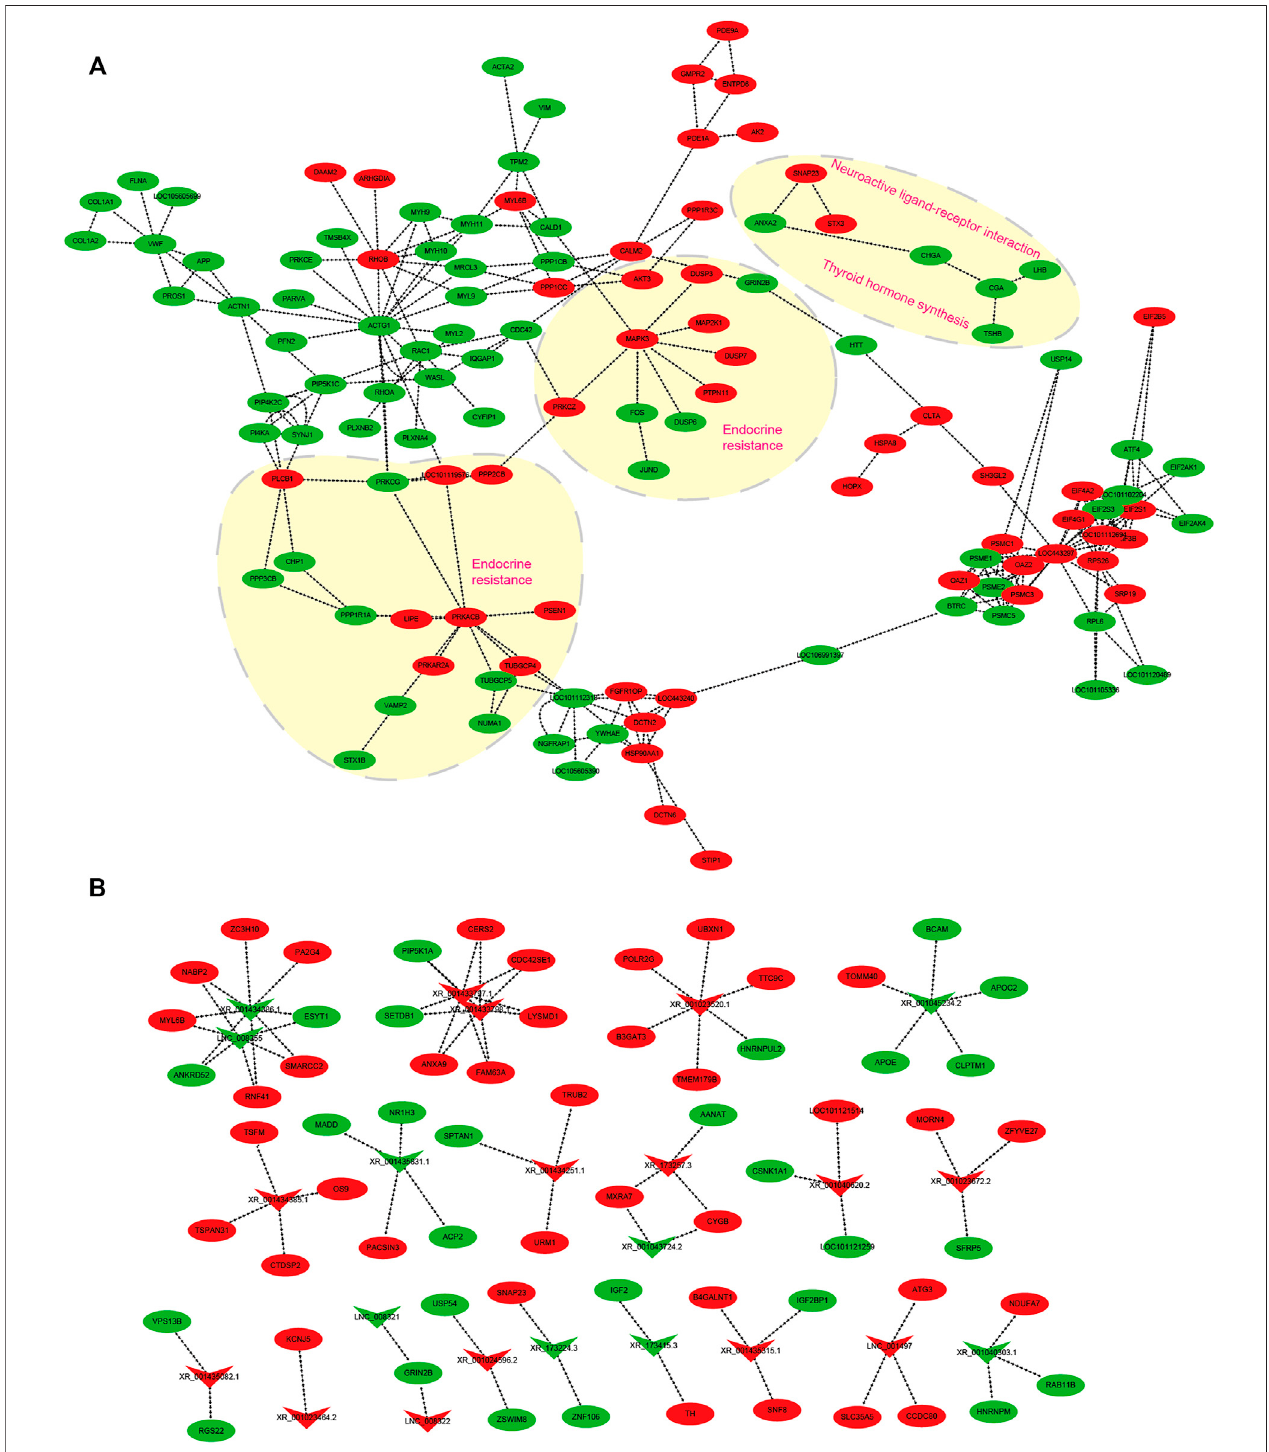
FIGURE 8 | Interaction network in the hypothalamus about ovine photoperiod responsiveness and estrous seasonality. (A) mRNA – mRNA interaction network involvedinphotoperiodicresponsiveness,thearrowdirectionrepresentsthetargetingdirection; (B) lncRNA – mRNAinteractionnetworkrelatedtoovineestrusregulation with the photoperiodic change. Circles and “ V ” represent mRNAs and lncRNAs, red and green represent upregulated and downregulated transcripts, respectively, and the arrow indicates the direction of the target relationship.